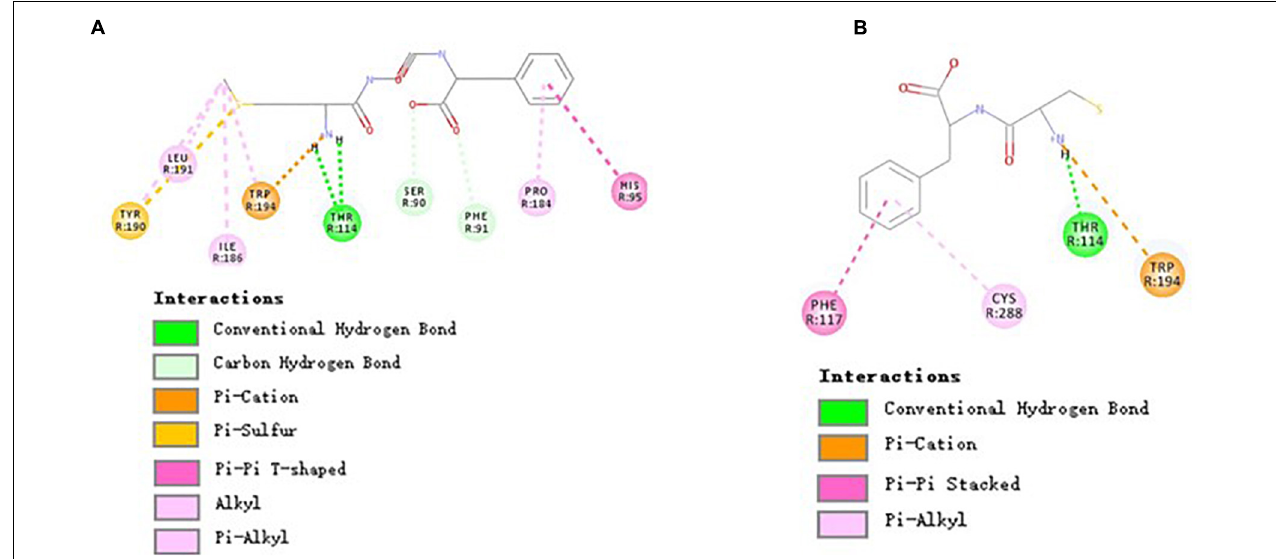
FIGURE 5 | Molecular interactions of MGF, CF, and CBR2. (A) Molecular interactions of MGF and CBR2. (B) Molecular interactions of CF and CBR2.